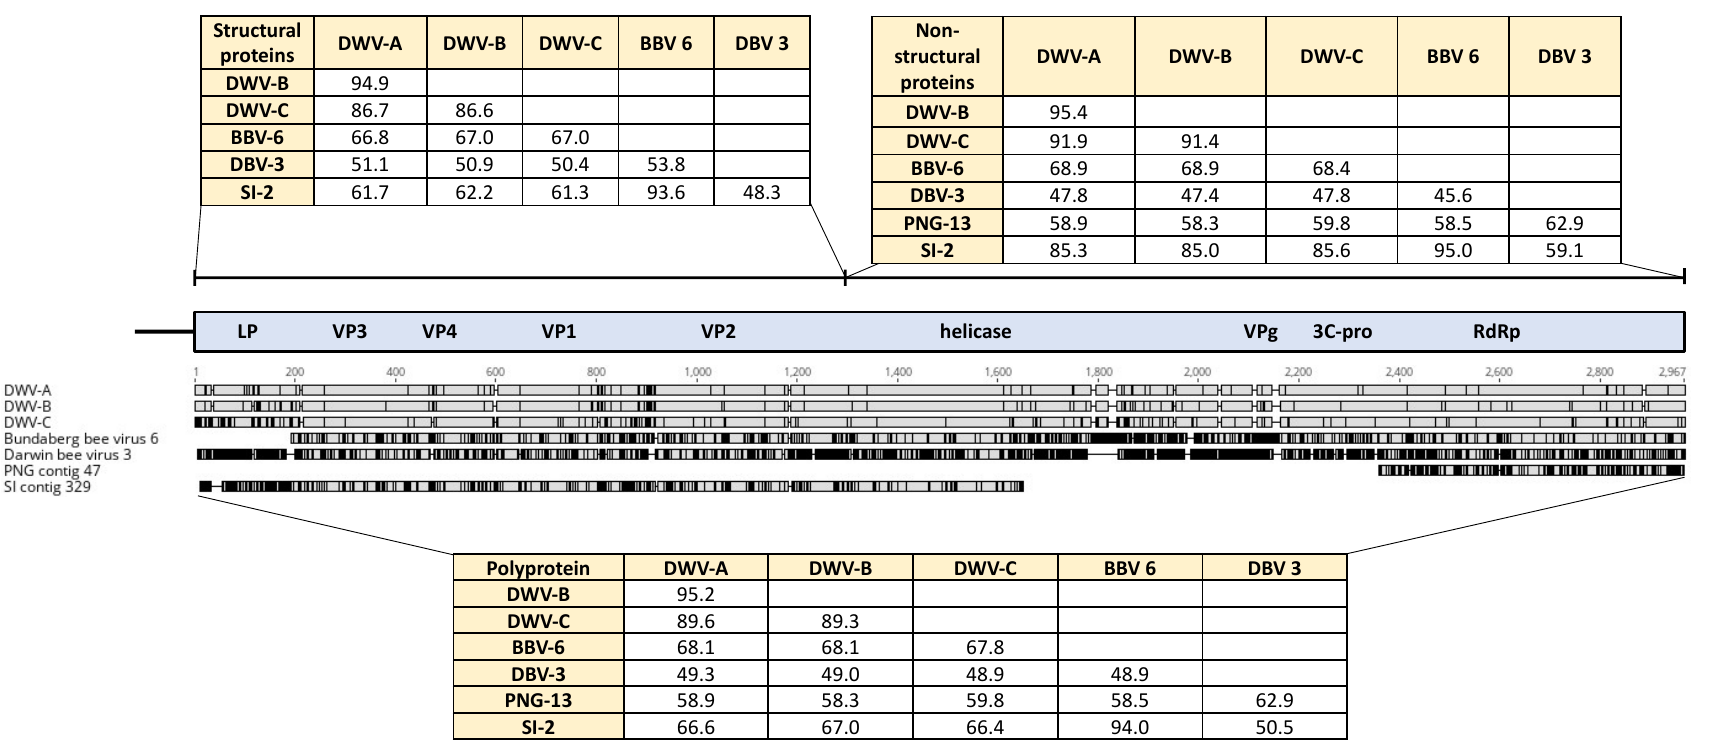
Figure 1. Amino acid alignment of novel virus sequences detected in Australia and the Pacific with DWV master variants. Percentage amino acid identities for the structural (leader protein, LP; viral coat proteins, VP) and non-structural (helicase; viral genome-linked protein, VPg; 3C protease, 3C-pro; RNA-dependent RNA polymerase, RdRp) protein regions of the viral genome are shown. BBV-6, Bundaberg bee virus 6; DBV-3, Darwin bee virus 3; PNG-13, PNG bee virus 13; SI-2 SI bee virus